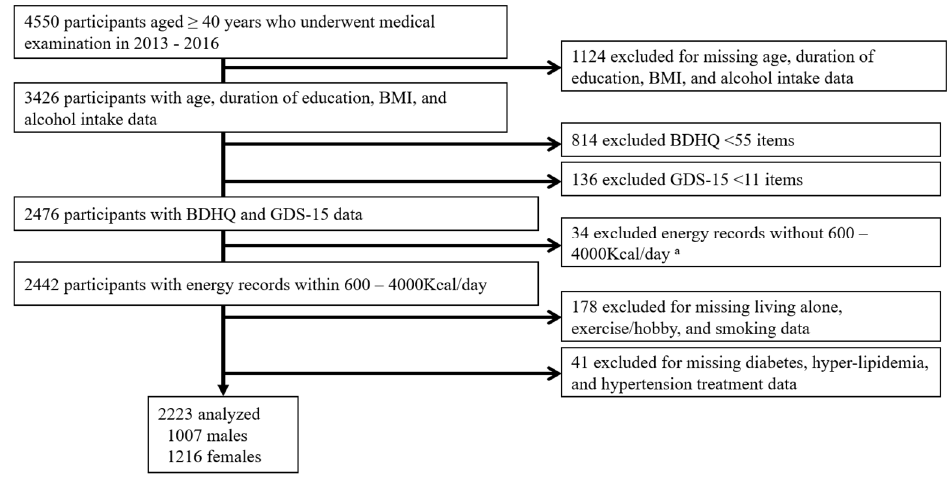
Figure 1. Participant recruitment chart. a This reference value was chosen for the following reasons: less than 600 kcal/day is equivalent to half the energy intake required for the lowest physical activity category; more than 4000 kcal/day is equivalent to 1.5 times the energy intake required for the medium physical activity category. Abbreviations: BMI, body mass index; BDHQ, brief-type self-administered diet history questionnaire; GDS, the Geriatric Depression Scale.